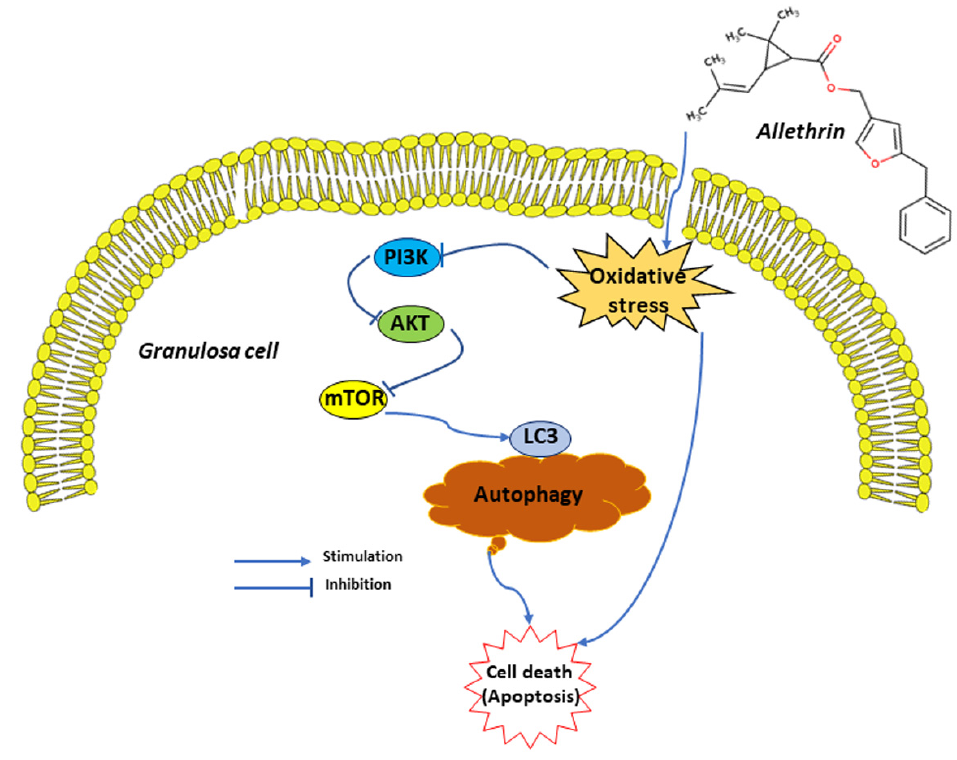
Figure 6. Schematic diagram of the effects of allethrin on ovarian cells, mainly granulosa cells.